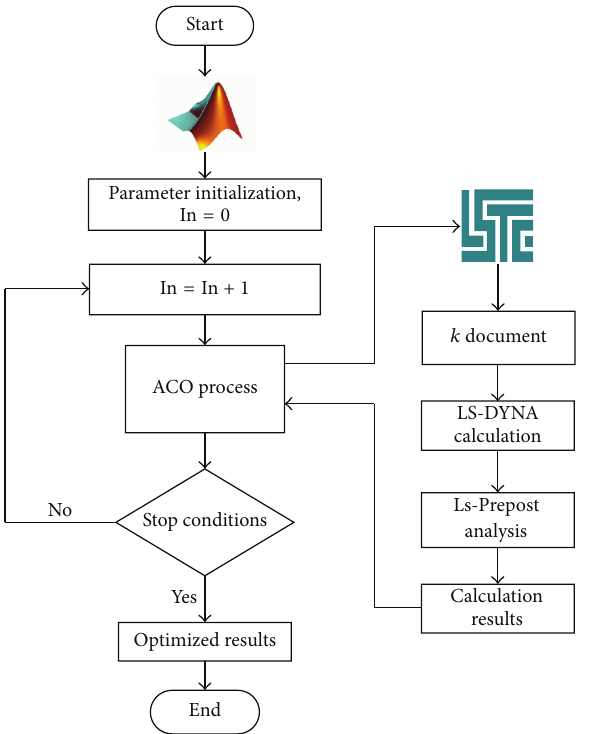
Figure 11: Program flow of FEM coupled with ACO.